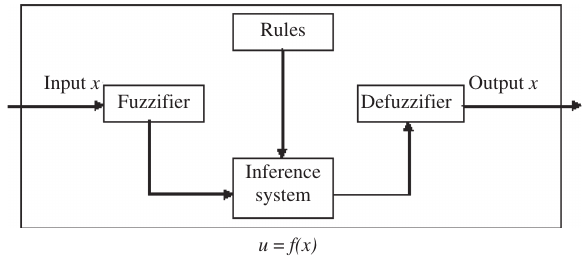
Figure 2: General Structure of